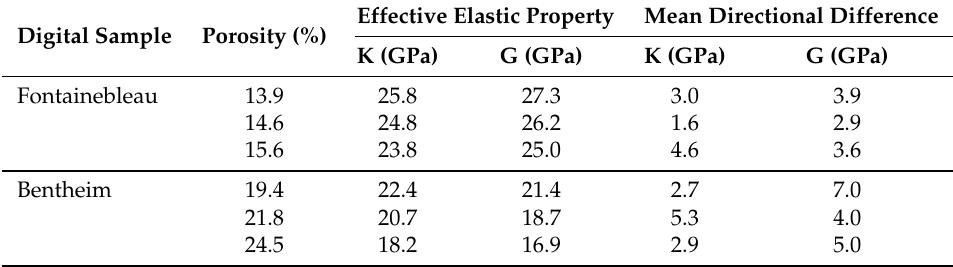
Table 3. Porosity as well as bulk (K) and shear (G) moduli of the representative